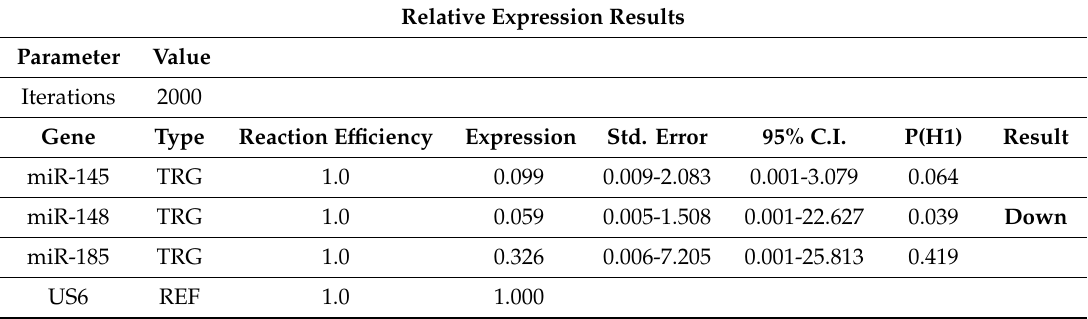
Table 2. Relative expression of miRNAs (WJ-MSCS by females compared to WJ-MSCs of males): standard error, 95% confidence interval (CI), and p -value of miRNAs.